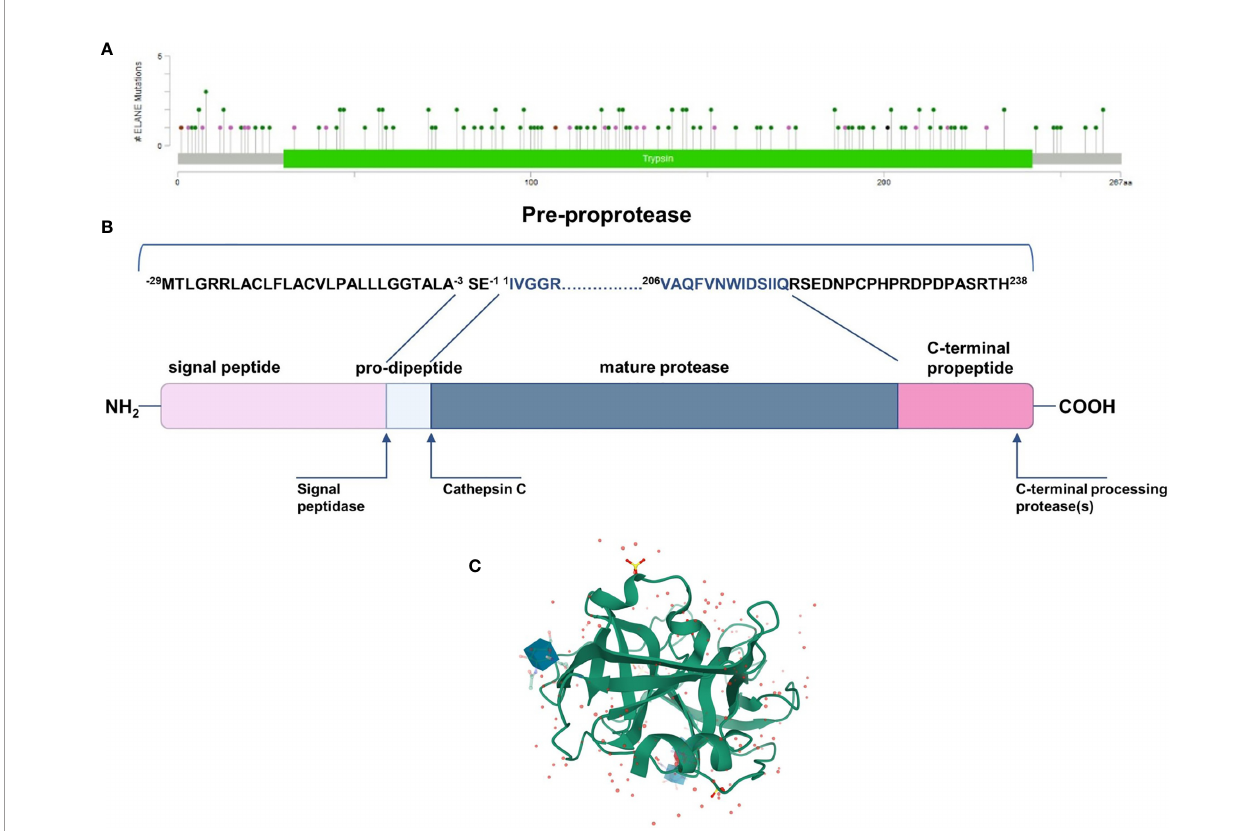
FIGURE 1 | (A) Mutational spectrum of the neutrophil elastase (ClinVar database; RefSeq NM_001972.4) (34). The lolliplot reports mutations projected on the schematic Trypsin domain of the human NE protein. The lolliplot was produced using the MutationMapper software, freely available through the Cbioportal (https:// www.cbioportal.org/mutation_mapper) (35, 36). In the scheme, mutations are reported as circles (green for missense mutations; black for duplication; brown for inframe deletions and insertions; violet for all the other types. (B) 267-residue preproprotein scheme and post-translational modi fi cation at both ends. (C) 3D structure of human neutrophil elastase 3Q76 (uncomplexed). Image created using Mol* from RCSB PDB (37,